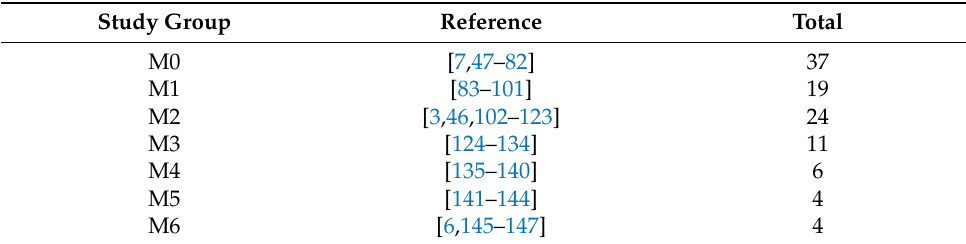
Table 4. List of study groups and their references.